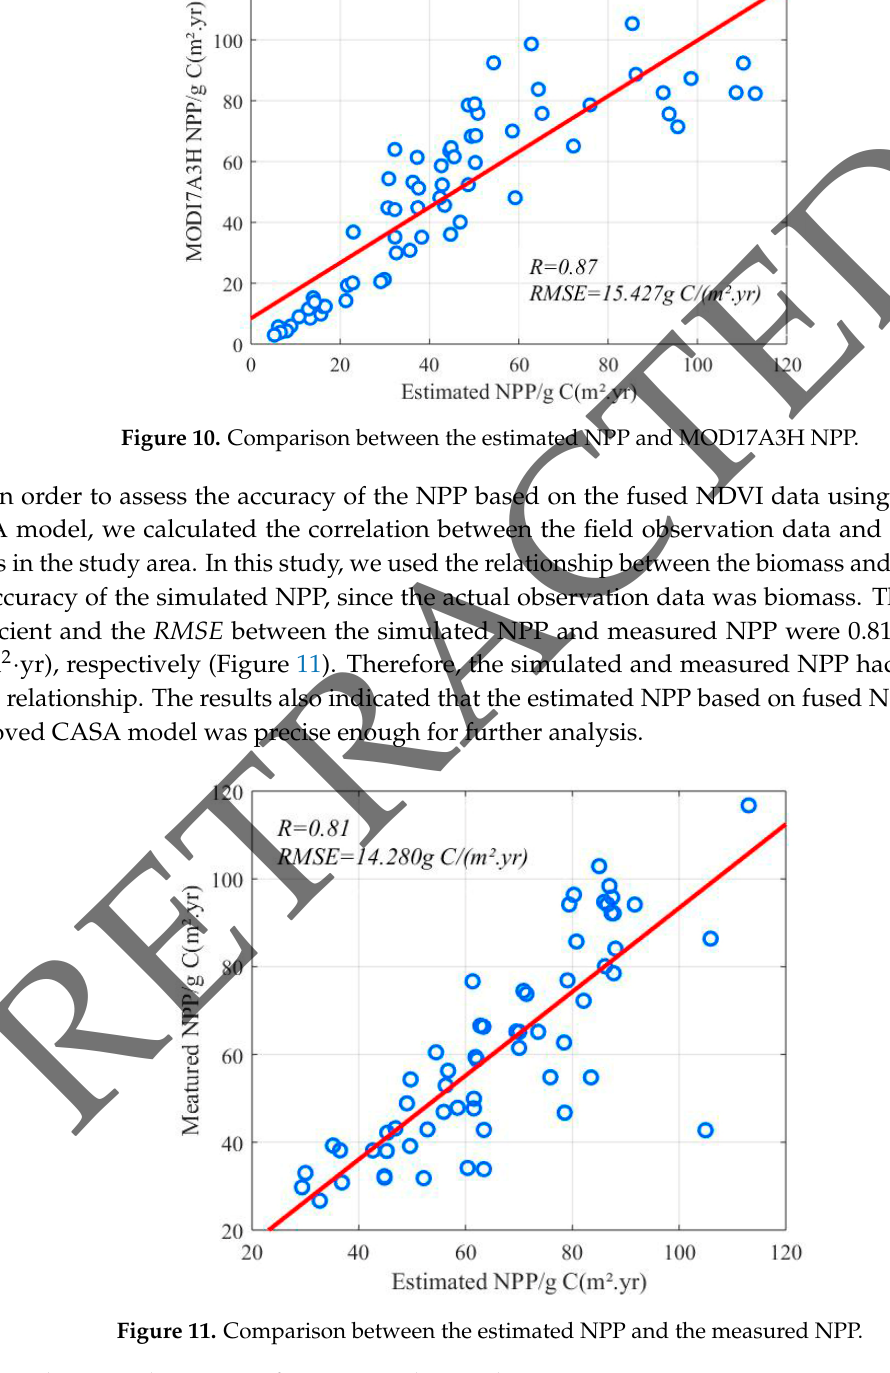
Figure 11. Comparison between the estimated NPP and the measured NPP.